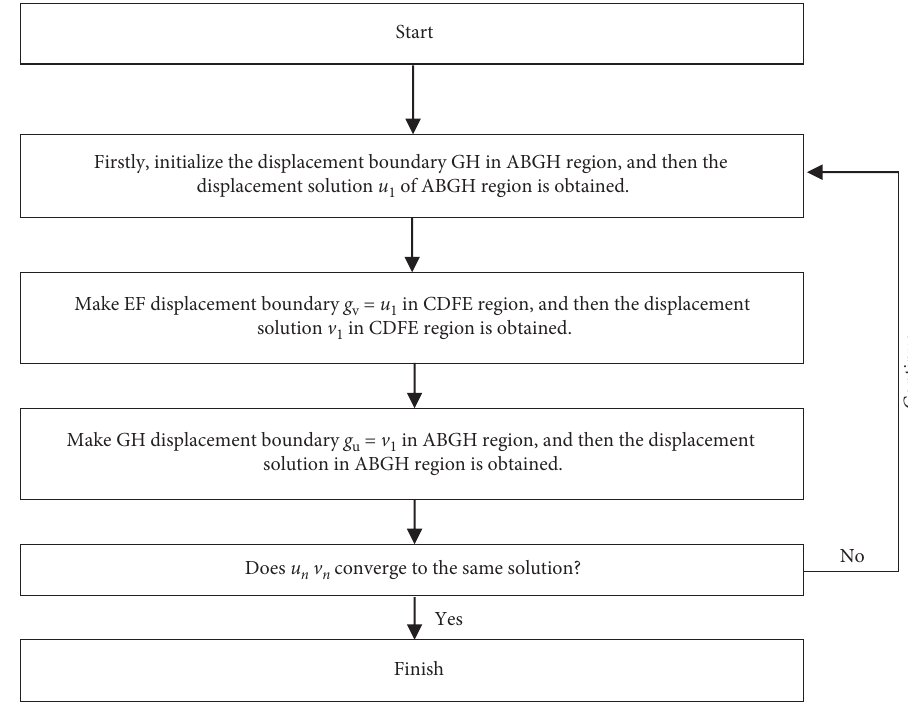
Figure 4: The basic process of Schwarz alternating